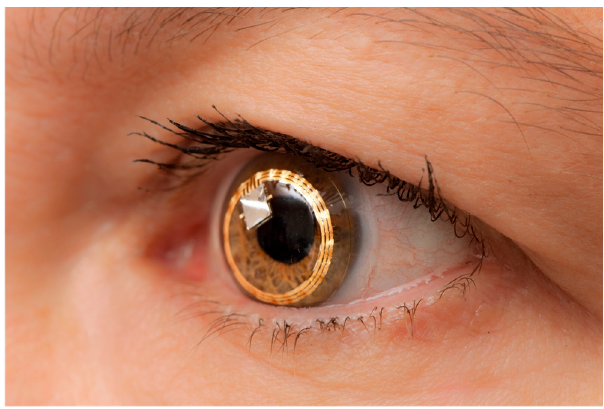
Figure 1. Triggerfish health monitoring lens device. The gold ringed antenna is used to communicate and power the lens through induction. Image was provided and reproduced with permission by ©Sensimed AG.